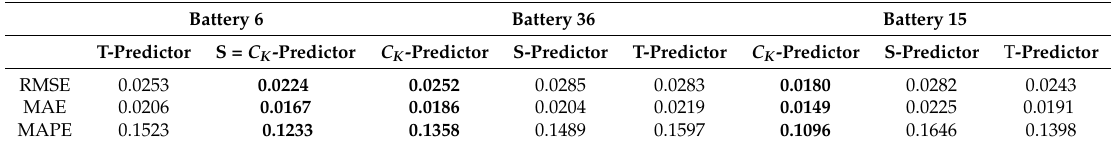
Table 6. Auto-Regressive Integrated Moving Average (ARIMA) performance comparison of k-shape-based Clustered predictor ( C K ), Single predictor (S), and Total predictor (T). RMSE = Root Mean Square Error; MAE = Mean Average Error; MAPE = Mean Average Percentage Error.